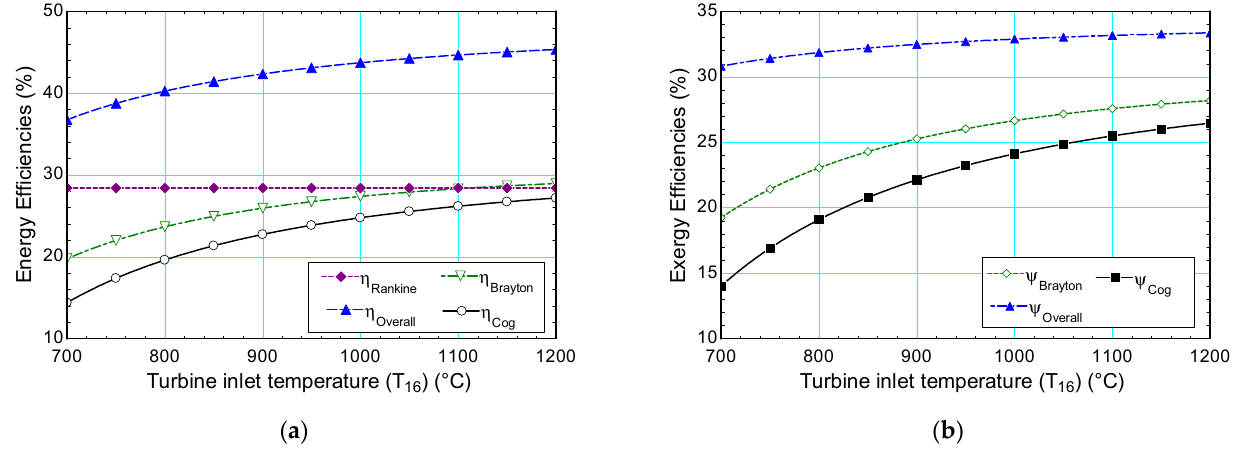
Figure 7. Turbine inlet temperature effect on: ( a ) energy efficiencies ( b ) exergy efficiencies.